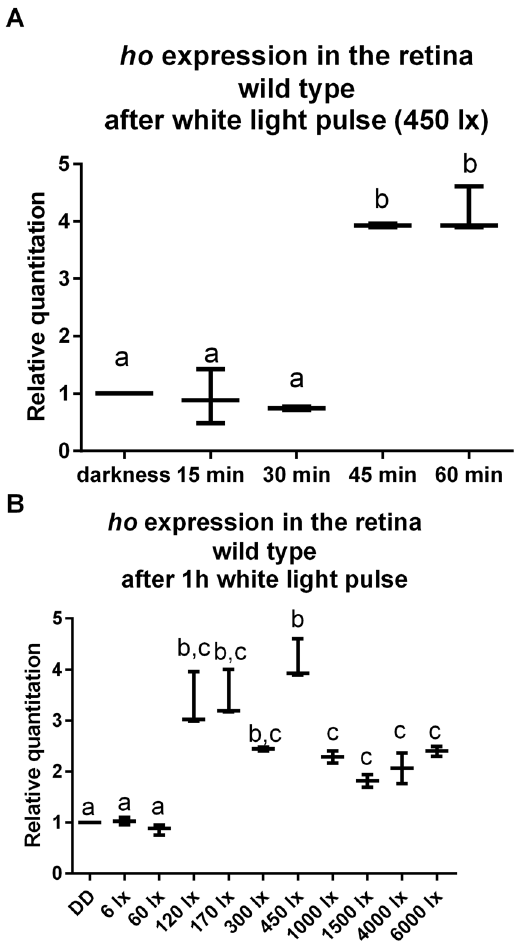
Figure 2. The ho gene mRNA level after different time (15 min, 30 min, 45 min, 60 min) of light exposure ( A ) and different light intensities ( B ) in the retina of wild type flies. Data are normalized to constant darkness (value = 1.0). Statistically significant differences are marked as different letters above bars. The ends of the vertical bars for each time point represent the range of findings, with the more centrally located horizontal bars the